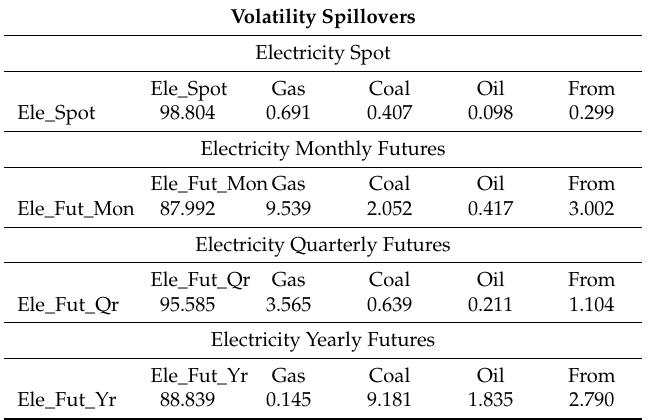
Table 7. The volatility spillover results of the Diebold–Yilmaz approach